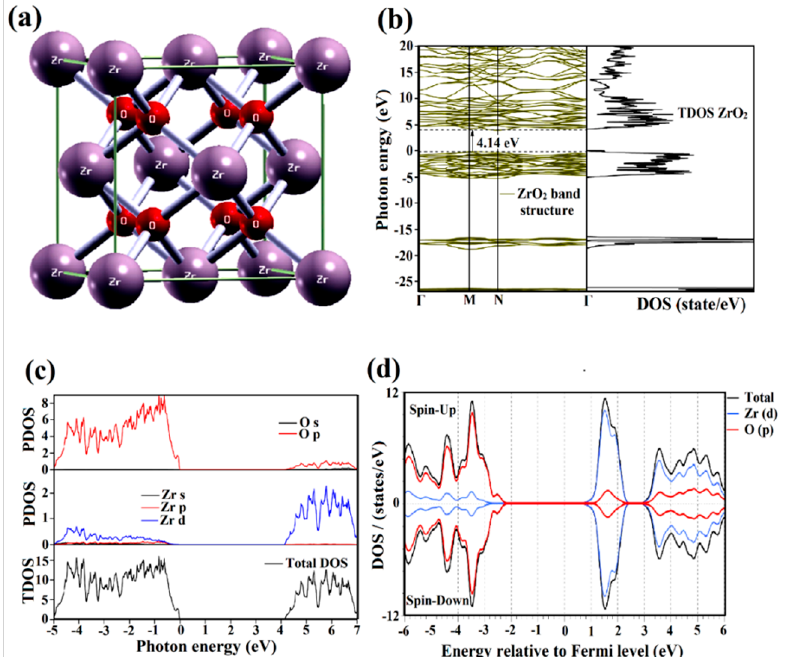
Figure 2. ( a ) Systematic diagram of pure ZrO 2 by Xcrysden package, reprinted with permission from Elsevier (License NO. 5332600596921) [32] ( b ) band structure and total density of state of ZrO 2 . ( c ) Partial density of states (PDOS) and total density of states (TDOS) of ZrO 2 , ( d ) PDOS and TDOS of pure ZrO 2 , reprinted with permission from Elsevier (License NO. 5332600898565)